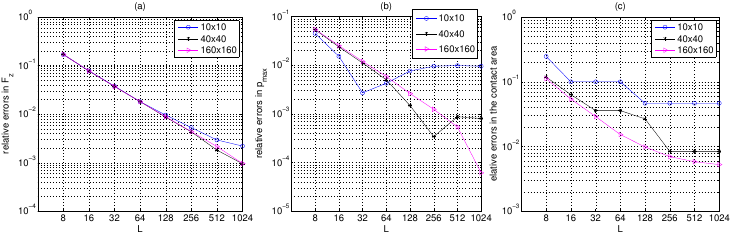
Figure 10. Normal contact problem with ICs by a piecewise constant load on hexahedron Mesh1: (a) errors in the normal force, (b) errors in the maximal pressure, (c) errors in the contact